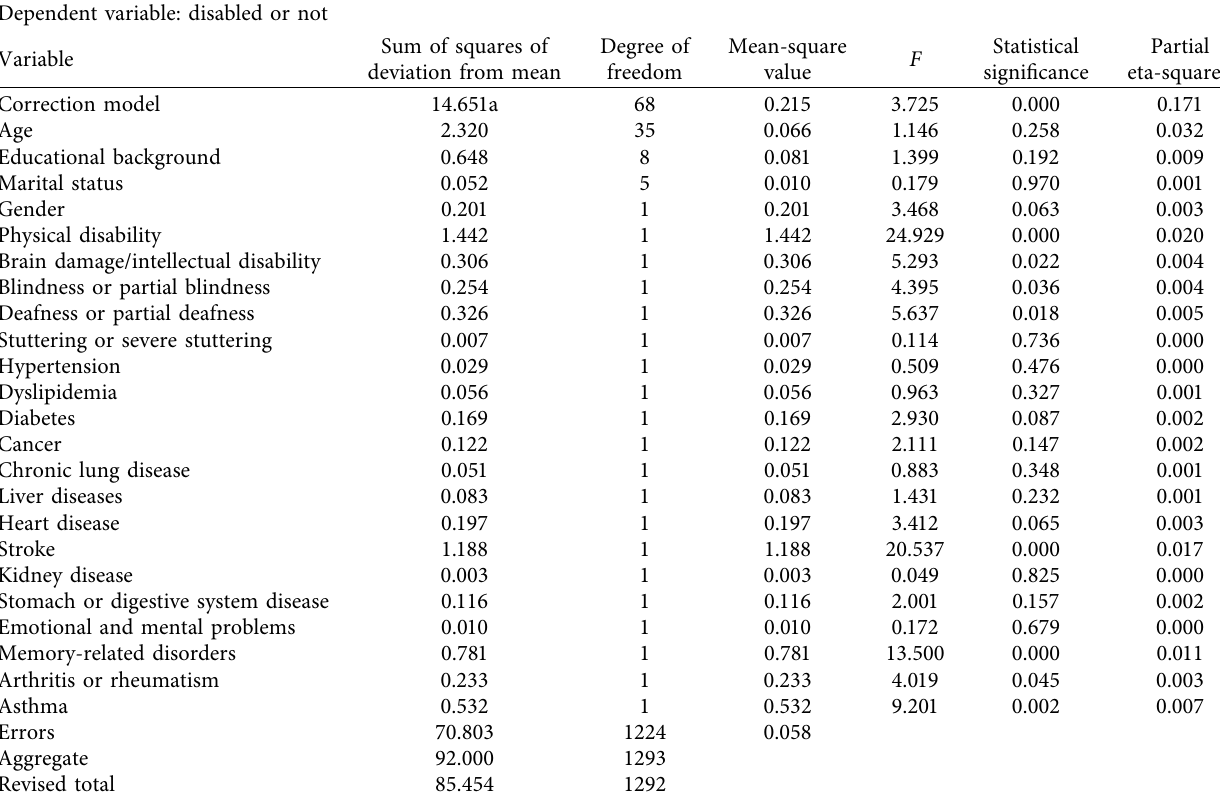
Table 1: Results from the multifactor analysis of